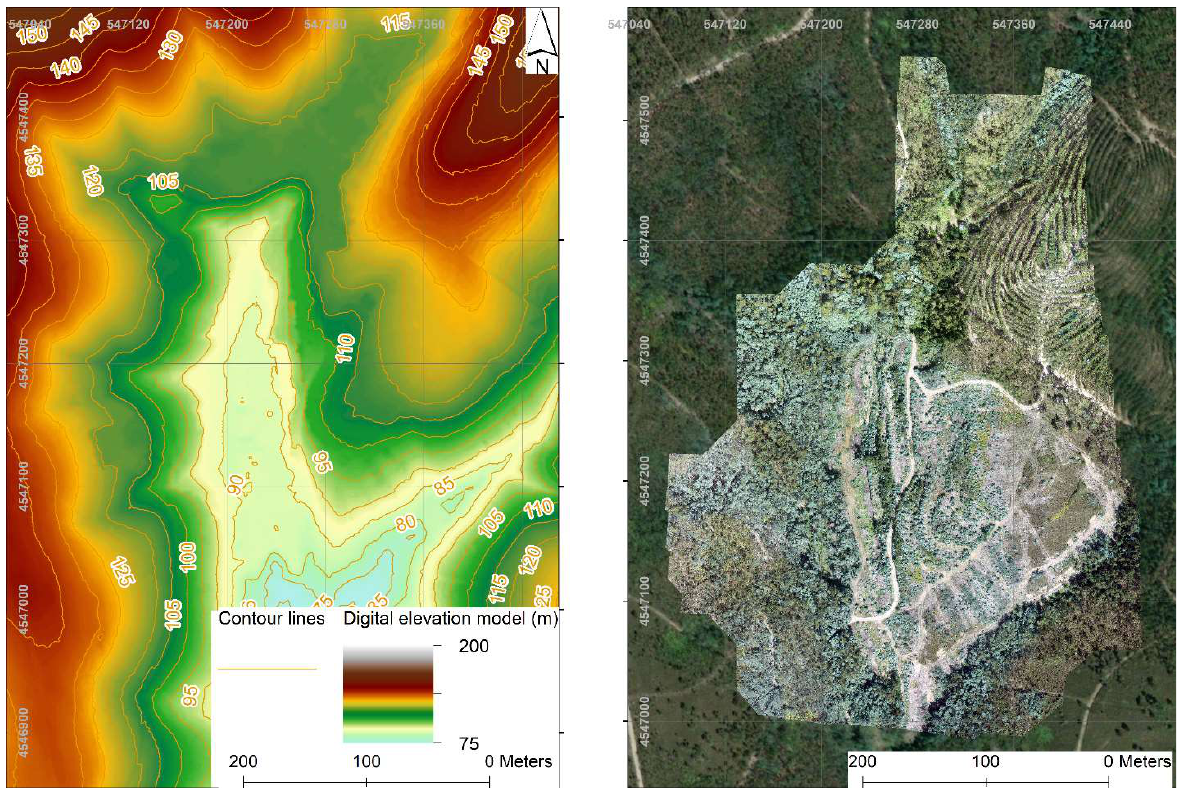
Figure 2. Topography survey o9f the site with a LIDAR-based drone system.